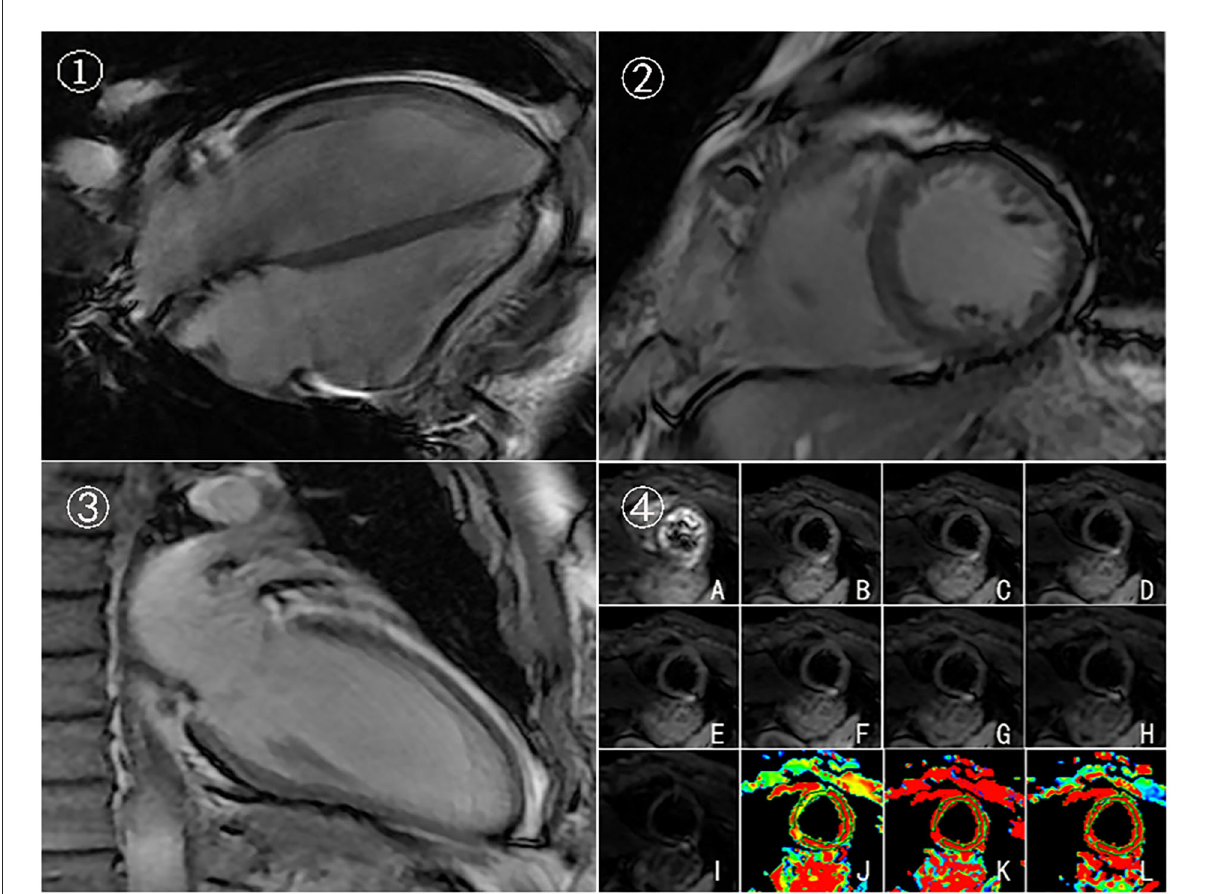
FIGURE2 Cine images and IVIM images of baseline. 4-chamber( ‹ ), left ventricle (LV) short-axis › , 2-chamber fi , and IVIM images fl of baseline. (A–I) Original images of IVIM at the left ventricular short-axis view (corresponding to b = 0, 20, 50, 80,100, 120, 200, 300, and 500 s/mm 2 , respectively). (J–L) Pseudocolor images were produced using the bi-exponential mode of the IVIM imaging system (corresponding to ADC slow , ADC fast , and f values, respectively).